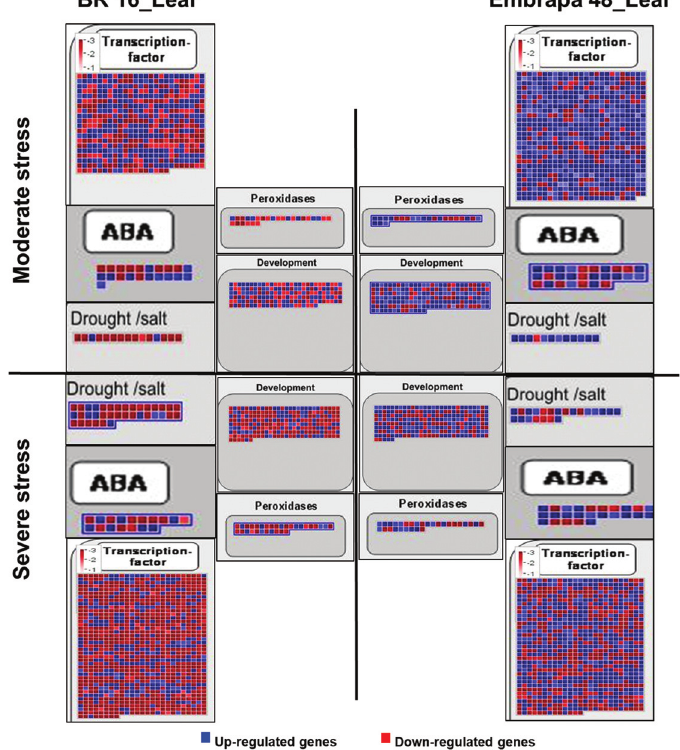
Figure 7 - Modified maps of MapMan 3.6 ORC. Genes that were differentially expressed in response to water deficit were mapped to specific stress-related pathways for leaf from BR 16 and Embrapa 48 under moderate and severe stress.The color scale shows the log2 fold-change: red = down-regulated and blue =